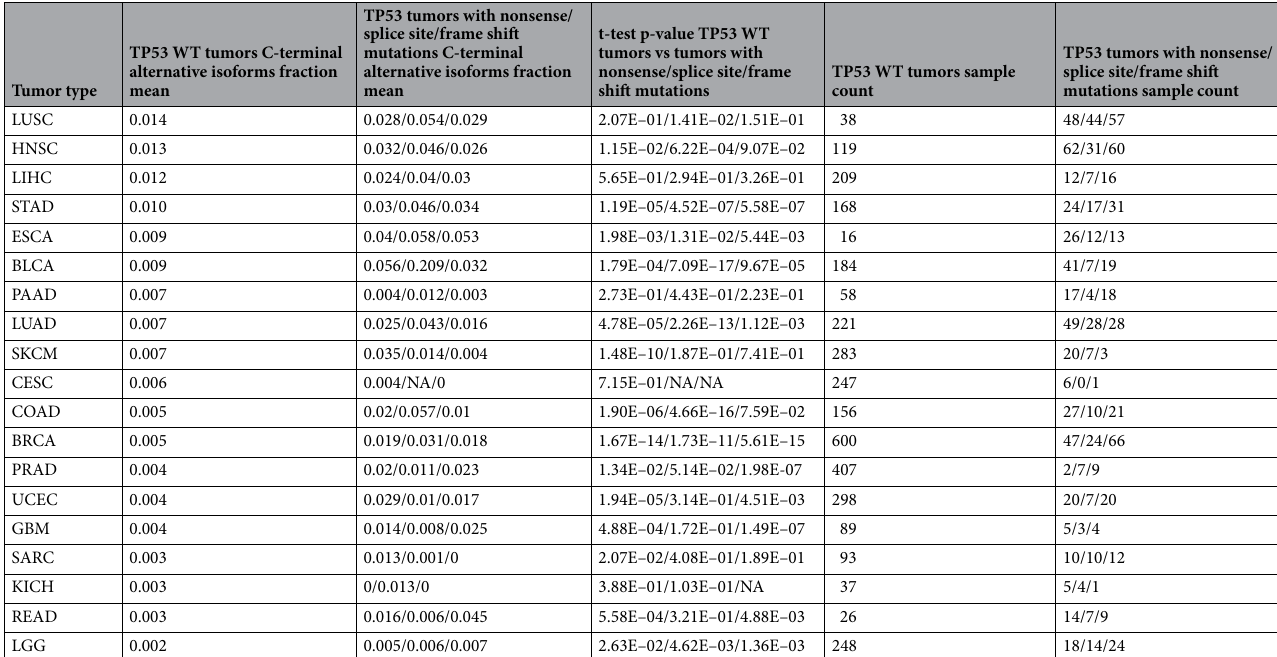
Table 3. Comparison of exonic fractions for C-terminal alternative isoforms across TCGA tumor types between TP53 WT tumors and TP53 tumors with frame shift, nonsense, splice sites